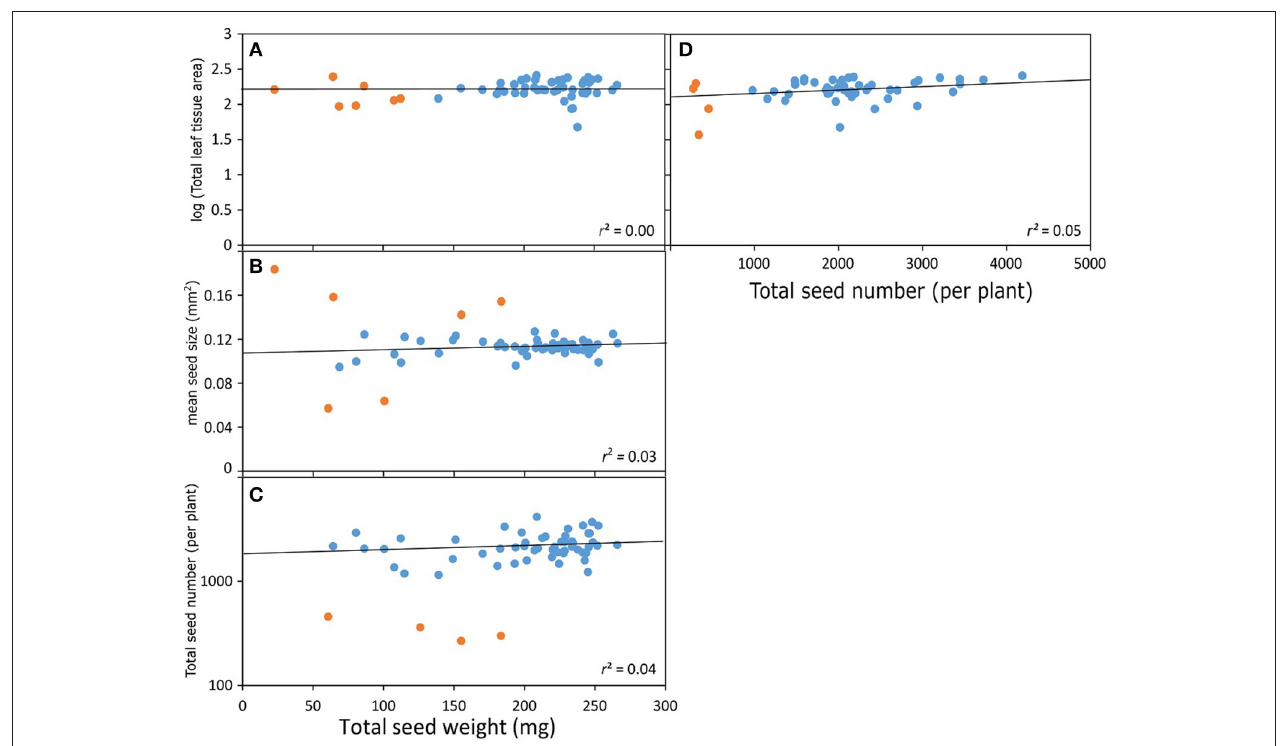
FIGURE 2 | Relationships between seed traits in Arabidopsis mutants (data from Van Daele et al., 2012). Total seed weight vs. (A) Total seed number per plant, (B) mean seed size, (C) total leaf tissue area. (D) Total seed number vs. total leaf tissue area. The orange dots correspond to a minority of outliers (mutants with extreme trait values) in each plot, whose inclusion into the dataset alters these relationships significantly. It is not a surprise that some of these orange data points include mutants and mutations in genes directly associated with seed size regulation. Regression lines and coefficients of determination are calculated without these outliers.